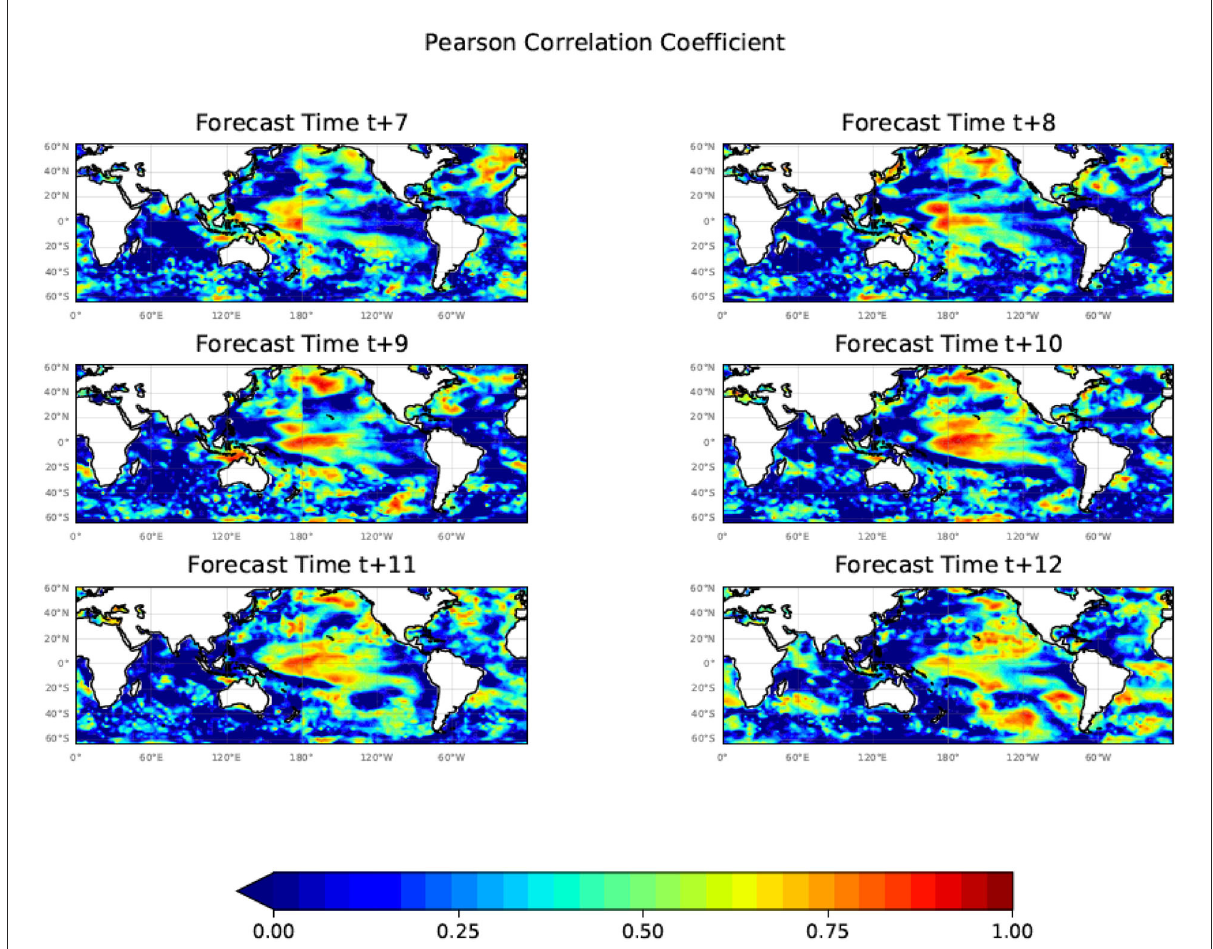
FIGURE10 The Pearson correlation coefficient (R) calculated using the 10 24-month forecasts commencing each July from July 2006 to July 2015 for months t+7 to t+12 showing the presence of a significant correlation between the model predicted and ERA5 SST values out to t+12. In order to use a 10-year period, part of the data for the correlation analysis is from the training period, however, the case studies in the model validation period of the study tend to support the correlation